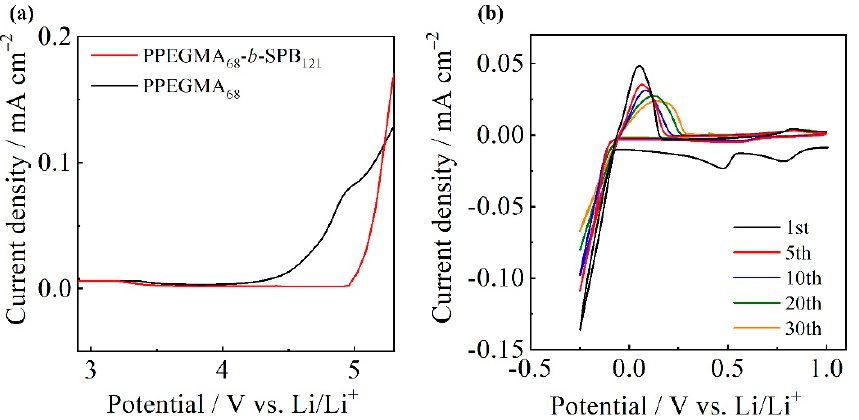
Figure 5. ( a ) Linear sweep voltammograms of PPEGMA 68 /LiTFSA and PPEGMA 68 - b -SPB 121 /LiTFSA at 60 °C (scan rate: 1 mV s − 1 ; working electrode: Pt; counter and reference electrodes: Li), and ( b ) cyclic voltammograms of PPEGMA 68 - b -SPB 121 /LiTFSA at 60 °C (scan rate: 10 mV s − 1 ; working electrode: Ni; counter and reference electrode: Li).